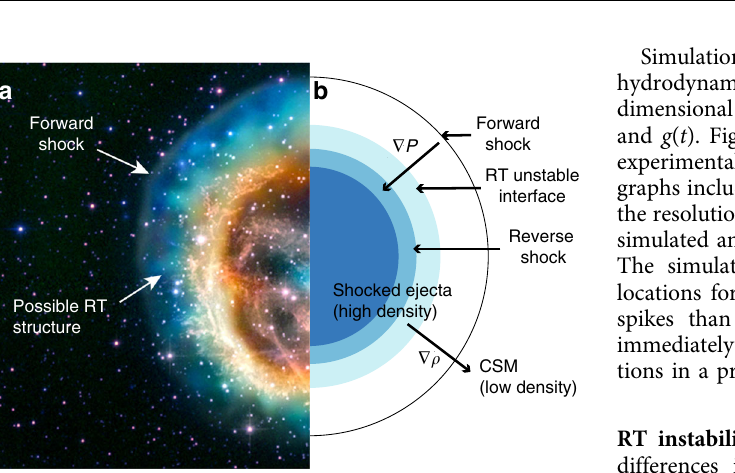
Fig. 4 Image of supernova remnant. a False-color image of SNR